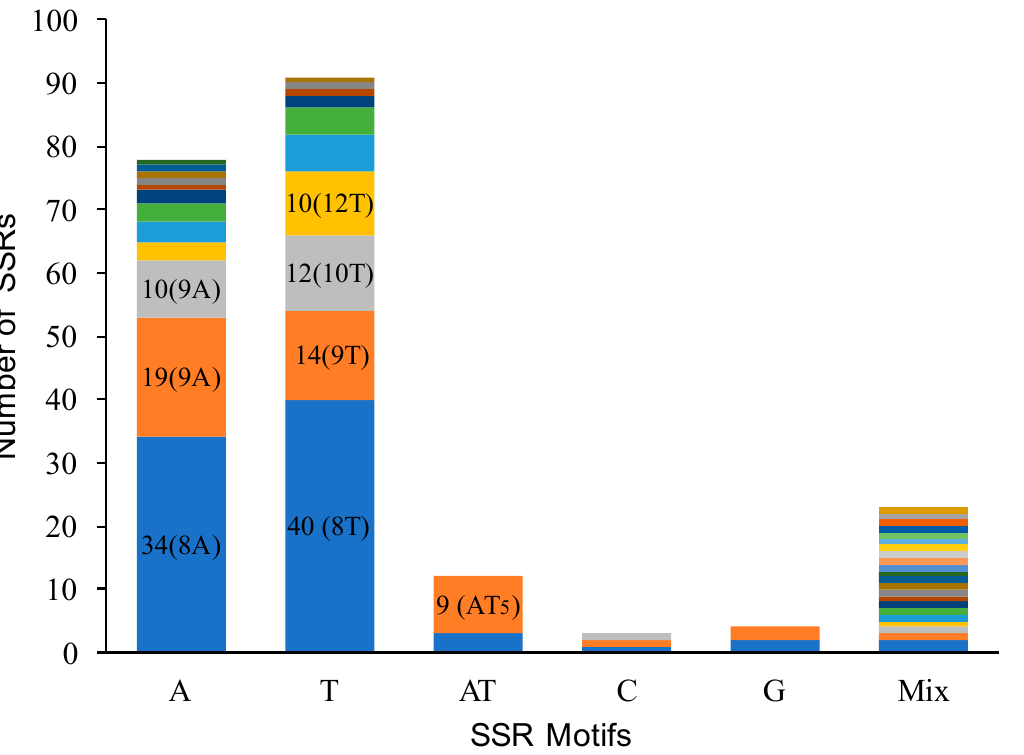
Figure 3. Frequency of different simple sequence repeat (SSR) types in the chloroplast genome of Z. jujuba .